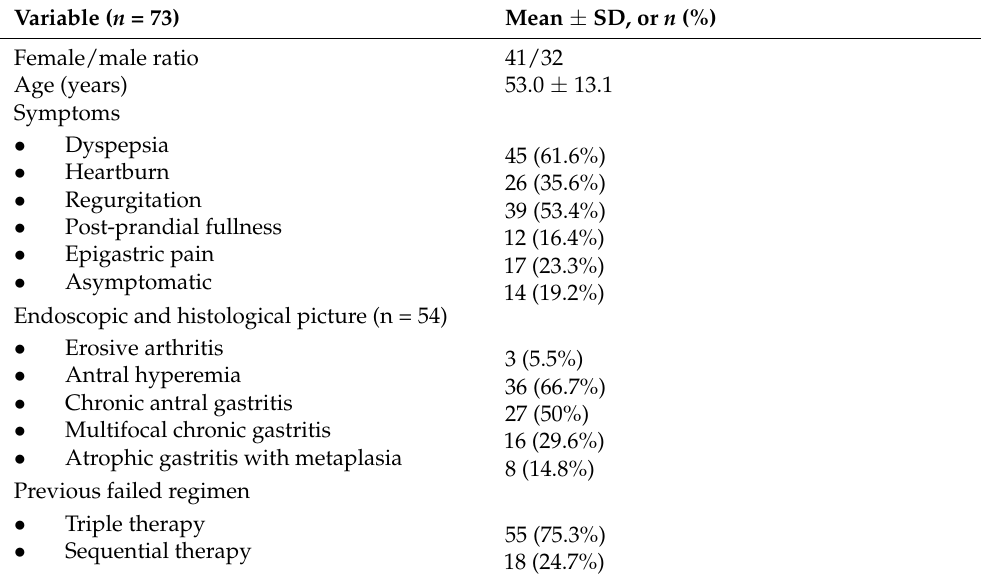
Table 1. Main demographic and clinical features of enrolled